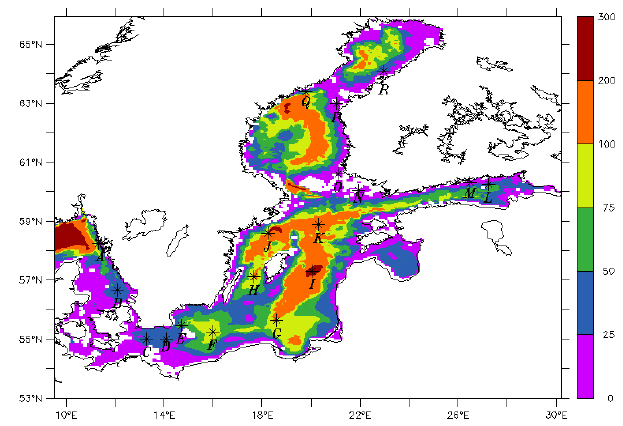
Fig. 1. Topography of the Baltic Sea (unit: m) and location of time- series observational stations A–R (marked with